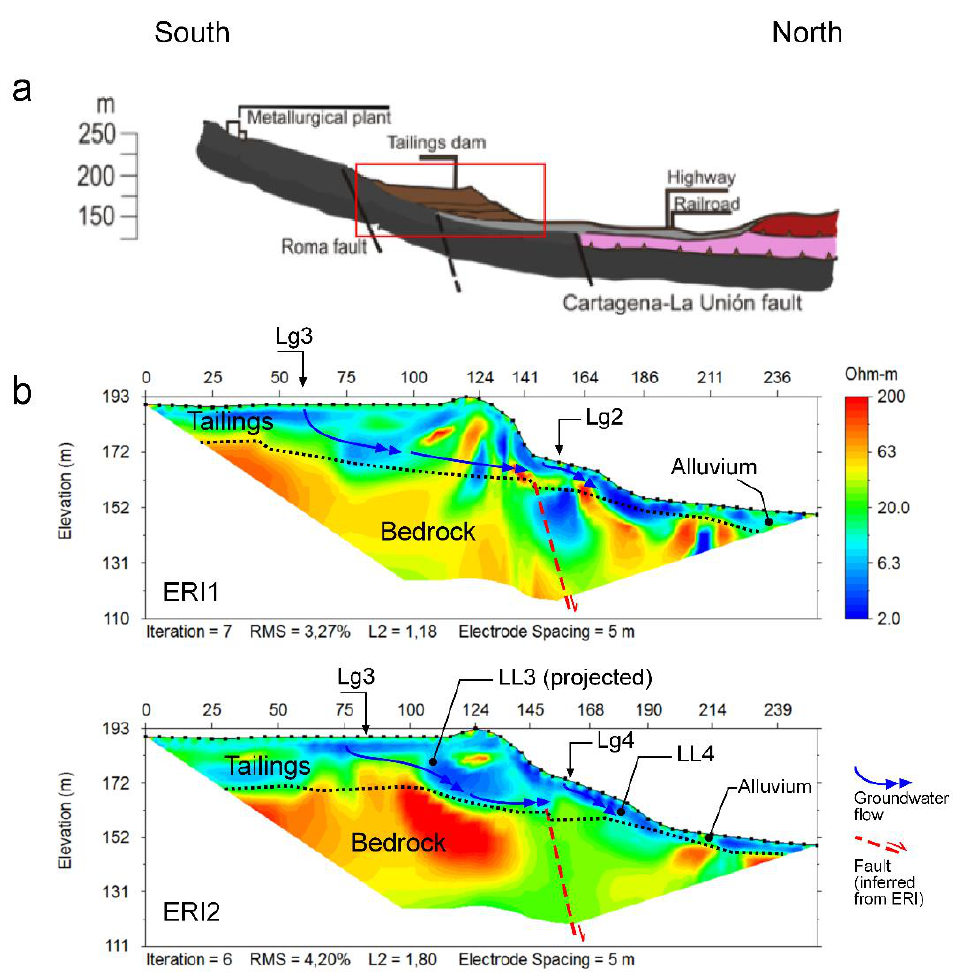
Figure 6. ( a ) Modeled geological profile S–N oriented along the El Descargador tailings dam emplacement. ( b ) Inverted resistivity images and tentative of geological interpretation of ERI1 and ERI2 collected by Wenner–Schlumberger array on the dam structure (see emplacements ERI1 and ERI2 in Figure 3a).